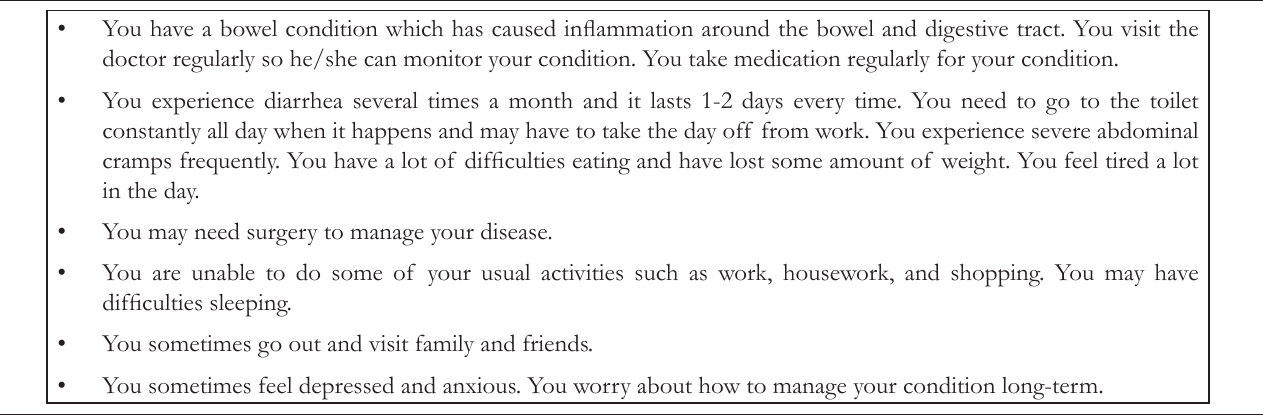
Figure 1: Example Health State Moderate to Severe CD (Reference